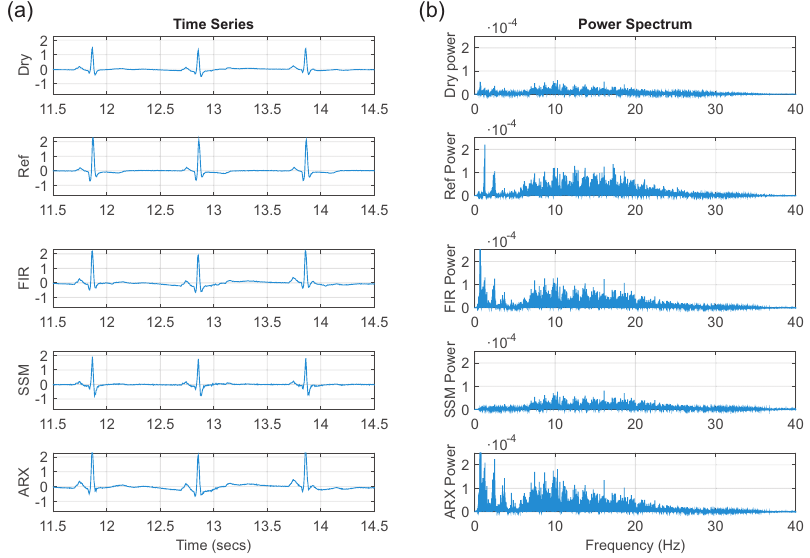
Figure 7. ( a ) ECG curves ( b ) Power Spectrum of uECG, reference ECG and estimated ECGs (FIR, SSM, ARX): (subject 1,